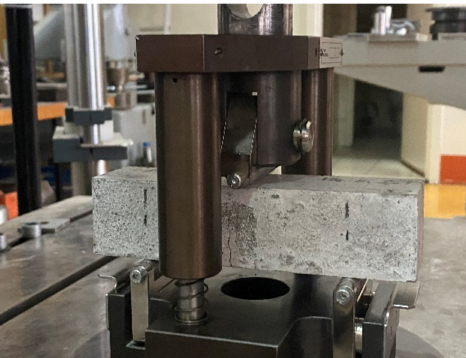
Figure 2. Toughness testing; positioning of the specimens and testing